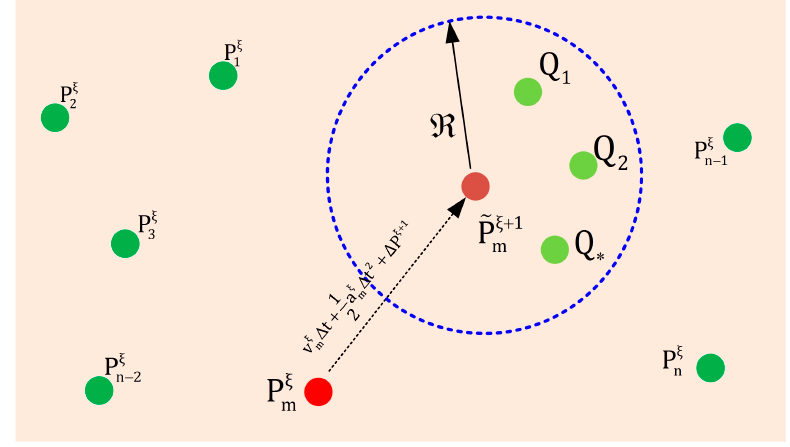
Figure 3. Schematic diagram of track correlation.